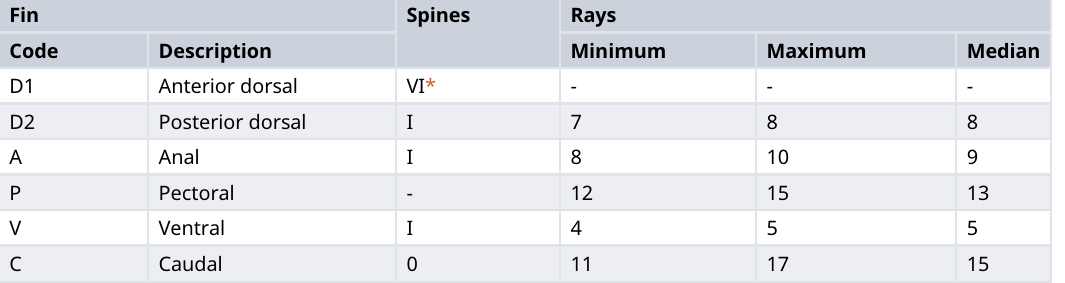
Table 4. Bolano Sau Lake payangka meristic characters (n=42).